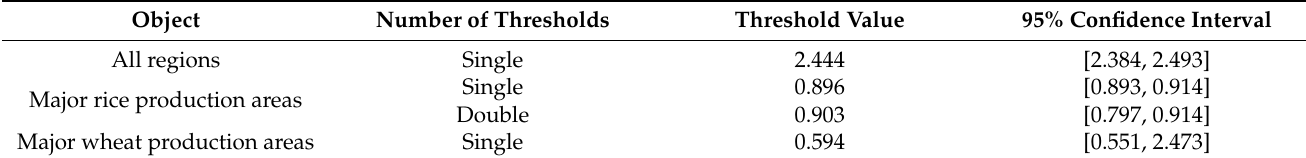
Table 5. Threshold effect test results 2: authenticity